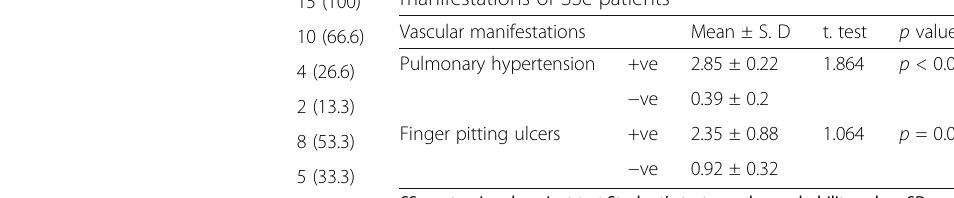
Table 3 Endocan levels in patients regarding